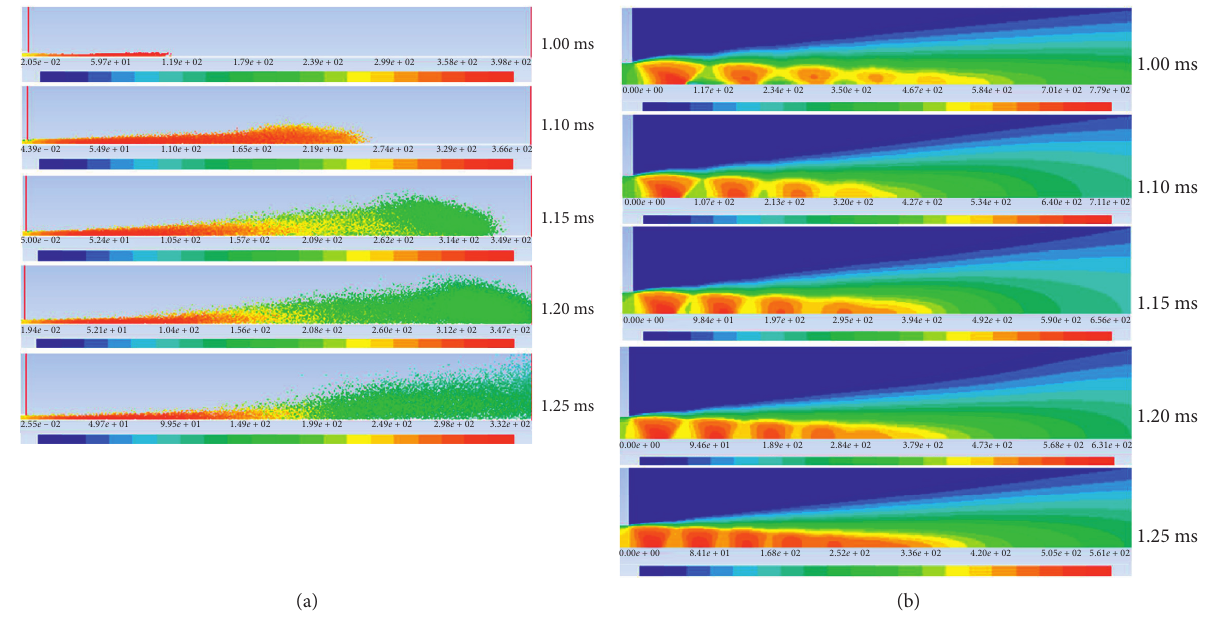
Figure 12: Particle distributions and Mach number contours at the exit of sonic nozzle. (a) Particle distributions. (b) Mach number